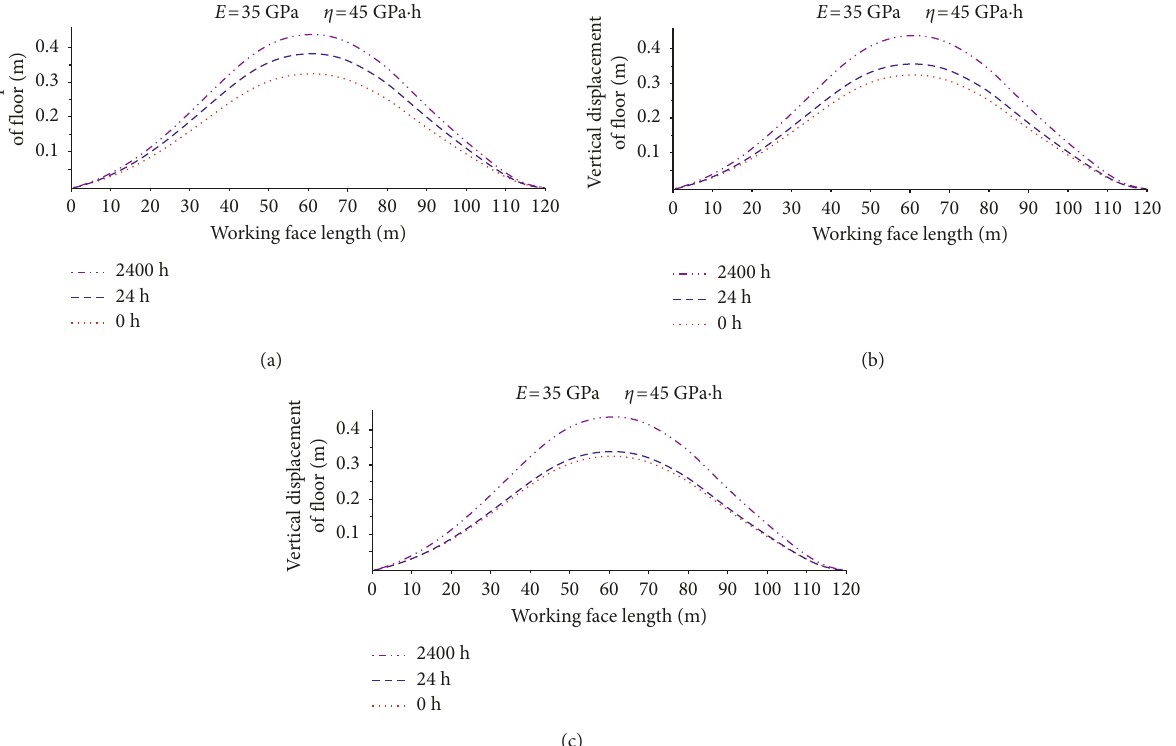
Figure 12: Deformation deflection curve with different viscosity coefficients. (a) η